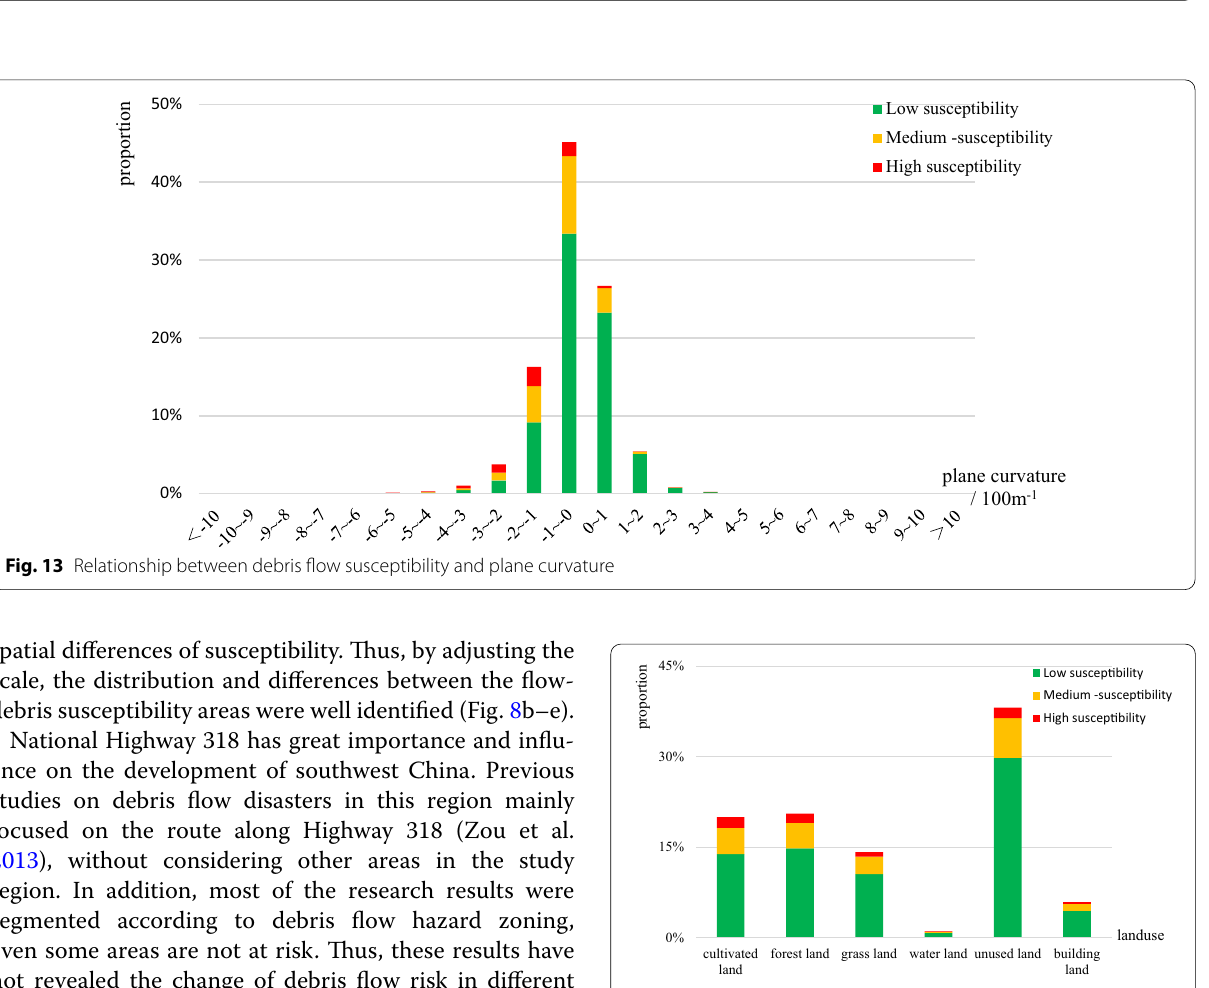
Fig. 14 Relationship between debris flow susceptibility and land